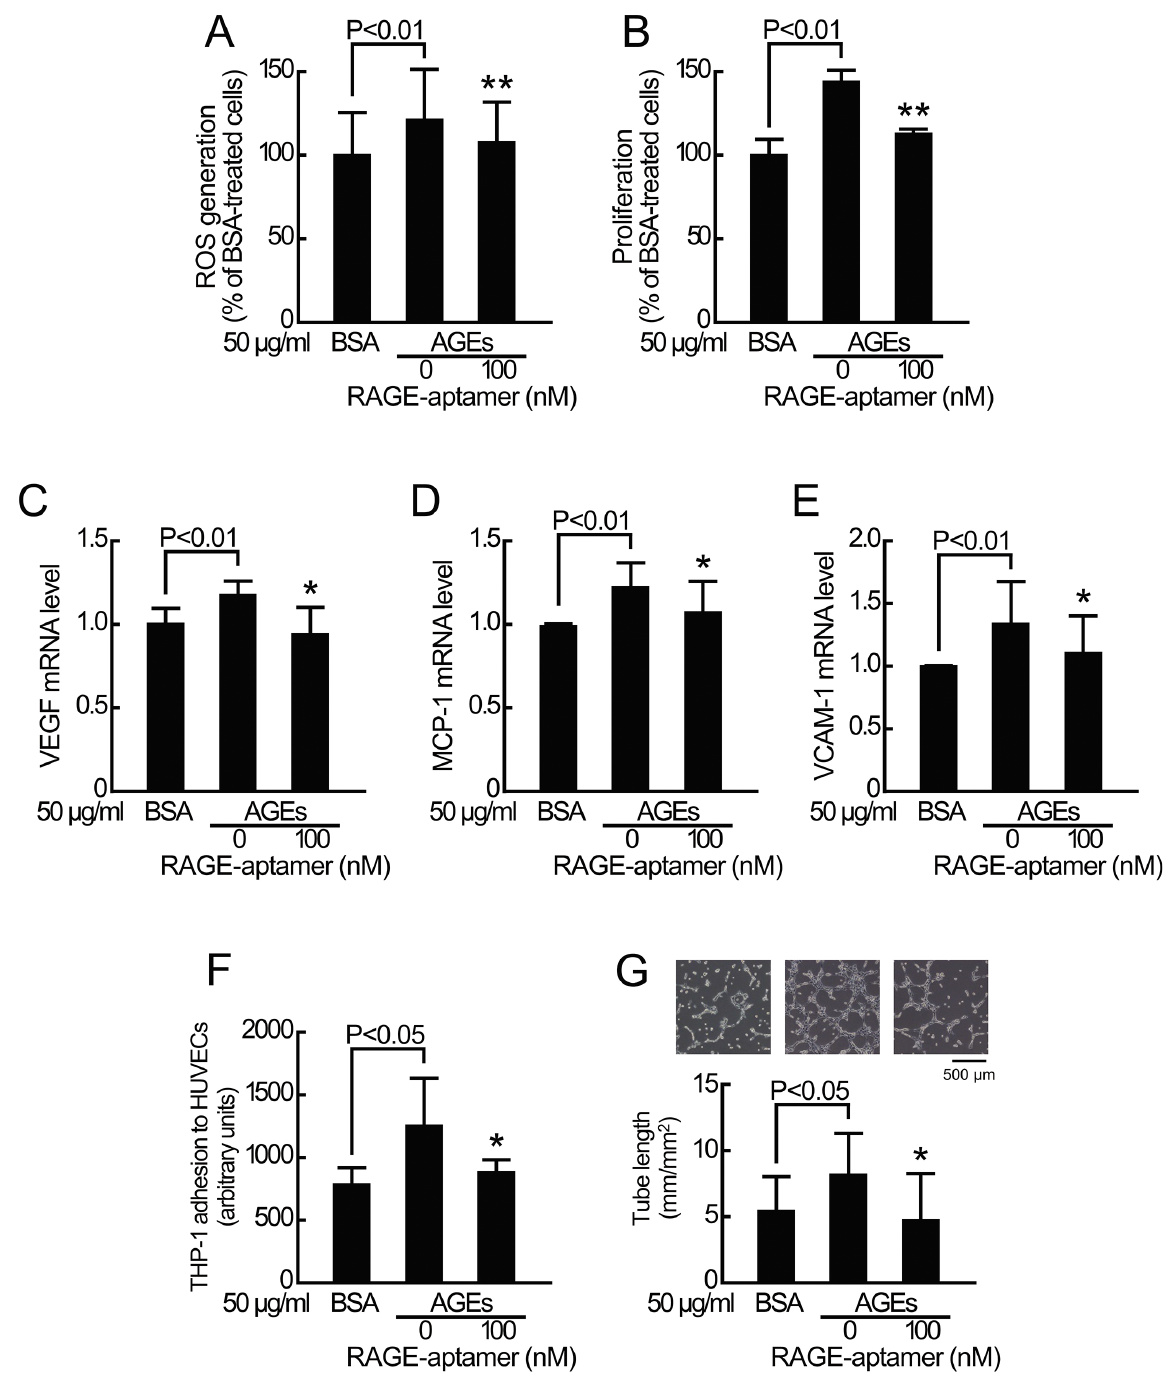
Figure 7. Effects of RAGE-aptamer on (A) ROS generation, (B) proliferation, (C) VEGF , (D) VCAM-1 and (E) MCP-1 mRNA levels in, (F) THP-1 cell adhesion to, and (G) tube formation of, AGE-exposed HUVECs. (A) Superoxide generation was evaluated by the fluo- rescence intensity of DHE staining. (B) Proliferation was determined by [ 3 H]thymidine incorporation into HUVECs. (C–E) Total RNA was transcribed and amplified by real-time PCR. Data were normalized by the intensity of β -actin–derived signals and related to the value obtained with nonglycated BSA alone. (G) Length of tube-like structures was measured. Upper panels show the representative micro- photographs. (A) N = 3 for each group. (B) N = 4 for each group. (C) N = 6 for each group. (D, E) N = 3 for each group. (F) N = 6 for each group. (G) N = 3 for each group. * and **, p < 0.05 and p < 0.01 compared with the value with AGEs alone,